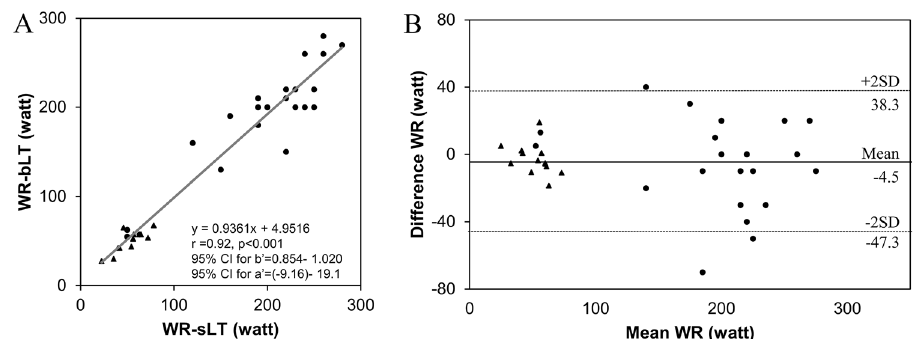
Figure 3. Validity testing of the WR at the sLT and bLT. ( A ) The graph shows the relationship between the work rate (WR) at the sLT and bLT. ( B ) The graph shows the Bland–Altman plots, which indicate the respective differences between WR at the sLT, and bLT (y-axis) for each individual against the mean of the WR at the sLT, and bLT (x-axis). Triangles indicate the data of patients and circles indicate the data of healthy subjects. r correlation coefficient, 95% CI for b’ 95% confidence interval for the slope, 95% CI for a’ 95% confidence interval for y-intercept, SD standard